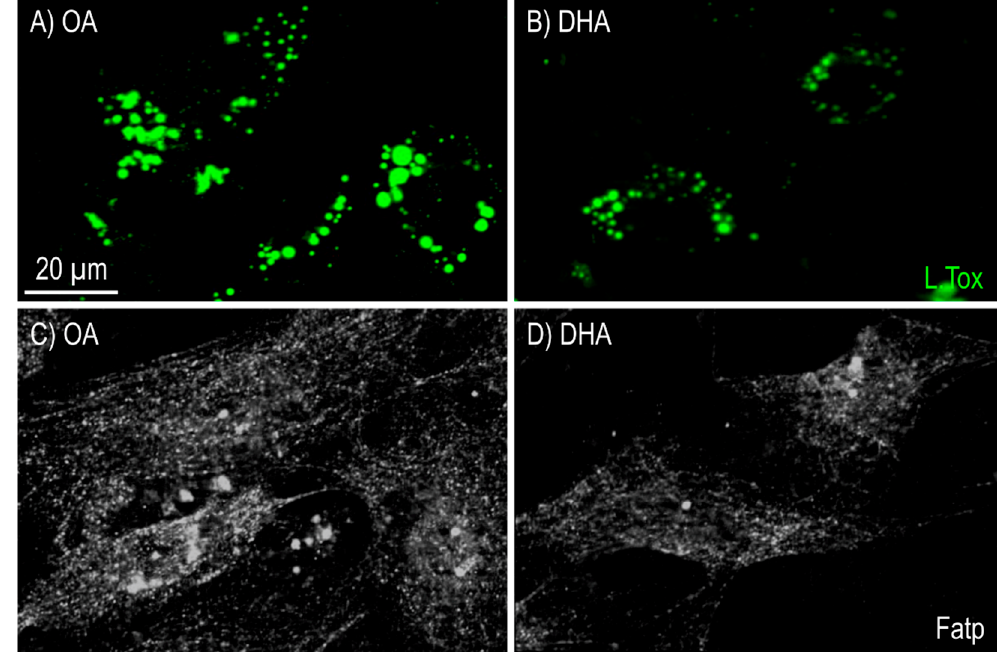
Figure 1. Imaging of lipid droplets by fluorescence microscopy stained with LipidTOX (green) in mature Atlantic salmon adipocytes in vitro incubated with oleic (OA) ( A ) or docosahexaenoic acid (DHA) ( B ) for 6 days. Immunofluorescence detection of fatty acid transport protein 1 (FATP1) level in mature Atlantic salmon adipocytes in vitro incubated with oleic (OA) ( C ) or docosahexaenoic acid (DHA) ( D ) for 6 days. 30 images were collected per treatment group (10 images per flask). One representative image for each treatment group is shown in this figure.